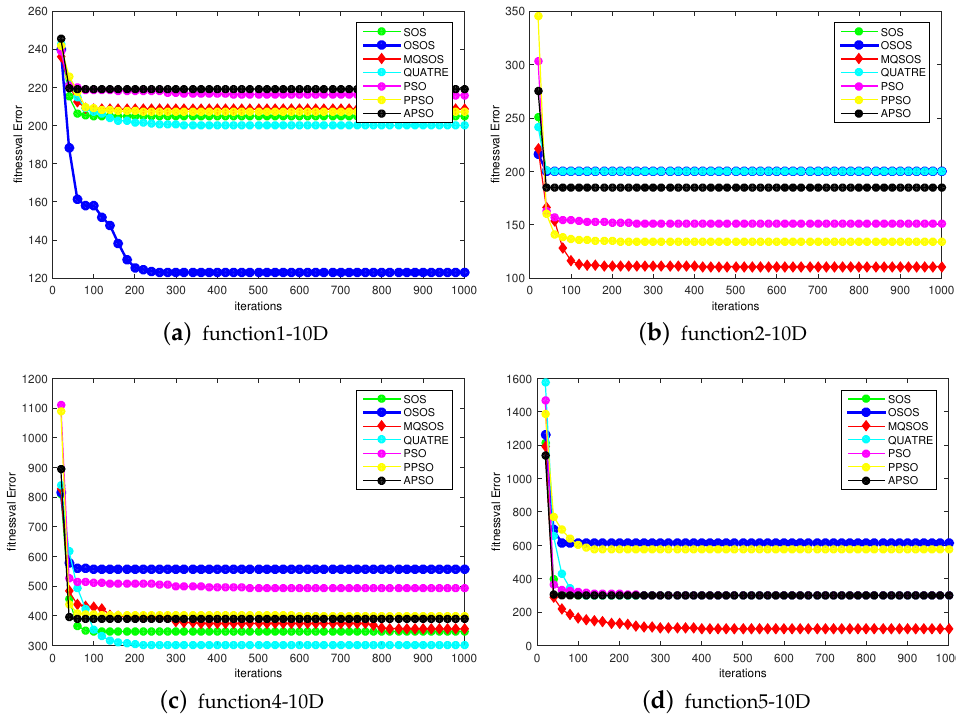
Figure 5. Comparison of the best fitnesses for functions f 25 − f 28 with 10D optimization.